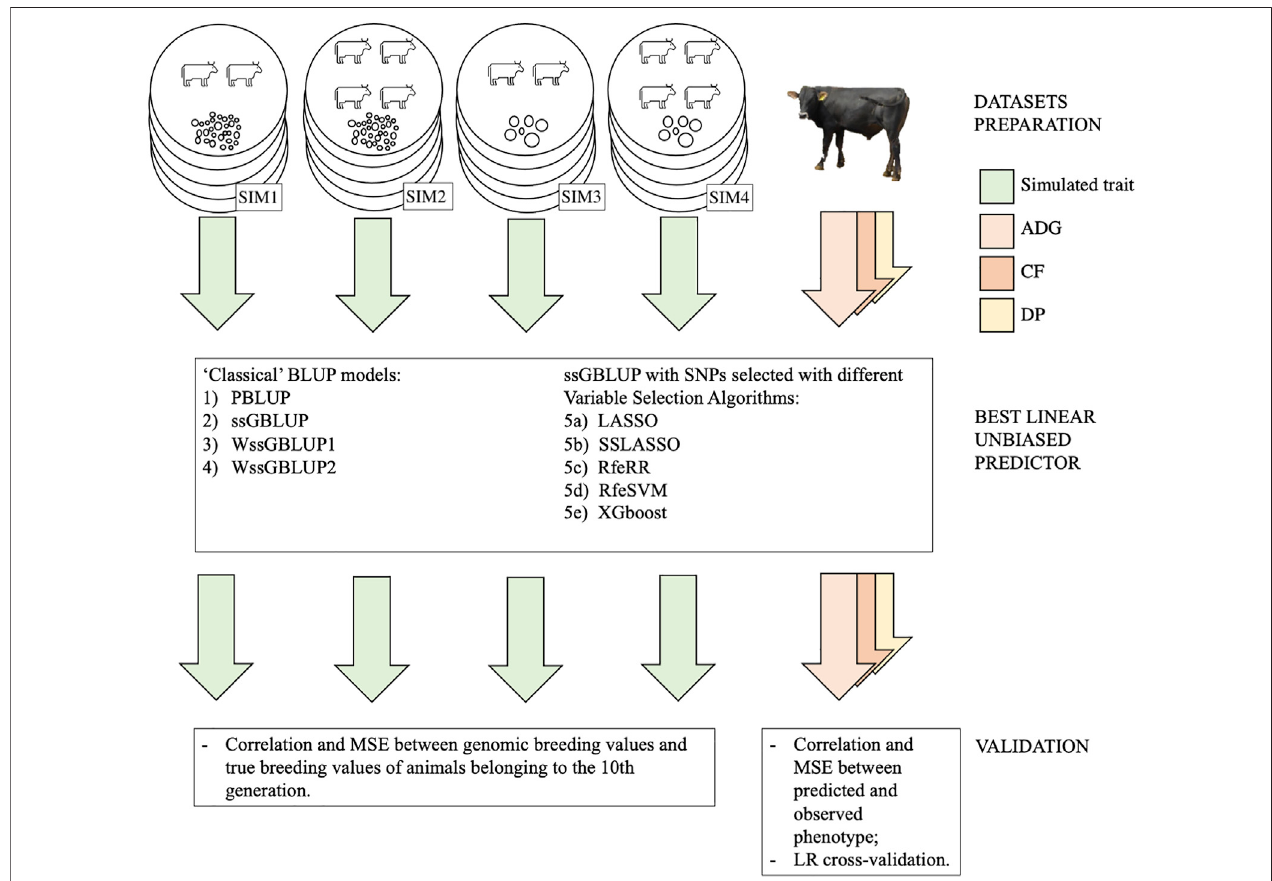
FIGURE 1 | Graphical representation of our methodology for testing model predictions both in simulated and real populations. Each replicate of a simulated populationisrepresentedwithacircle;SIM1ispolygenicwithlowMe,SIM2polygenicwithhighMe,SIM3isoligogenicwithlowMe,andSIM4isoligogenicwithhighMe. Each phenotype (both real and simulated) is represented with an arrow.